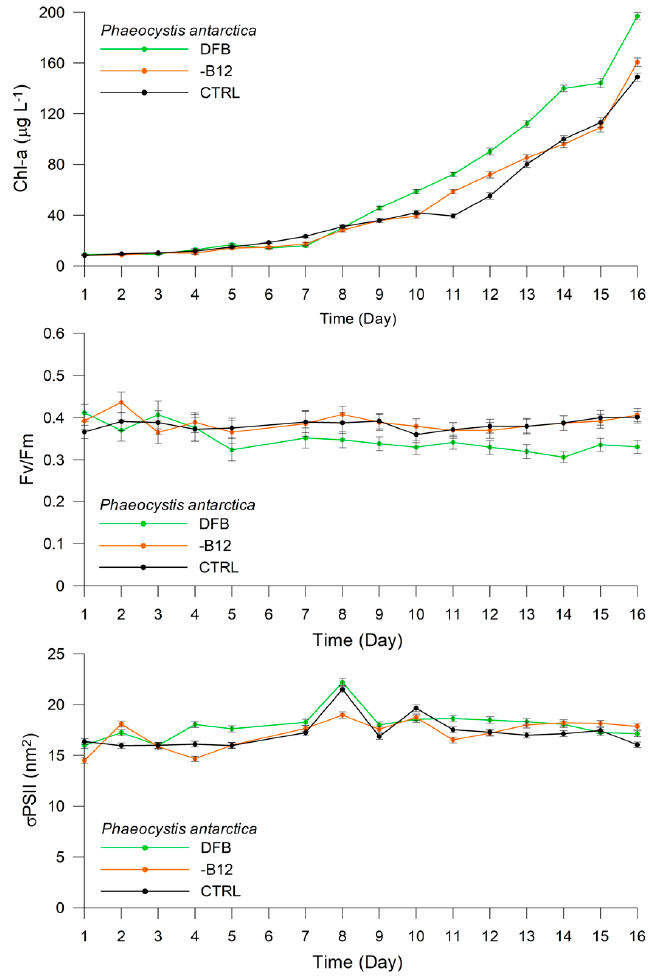
Figure 4. Experiment 1. Changes in Chl-a concentration ( µ g L − 1 ), Fv / Fm, and σ PSII (nm 2 ) in Phaeocystis antarctica under different treatments.